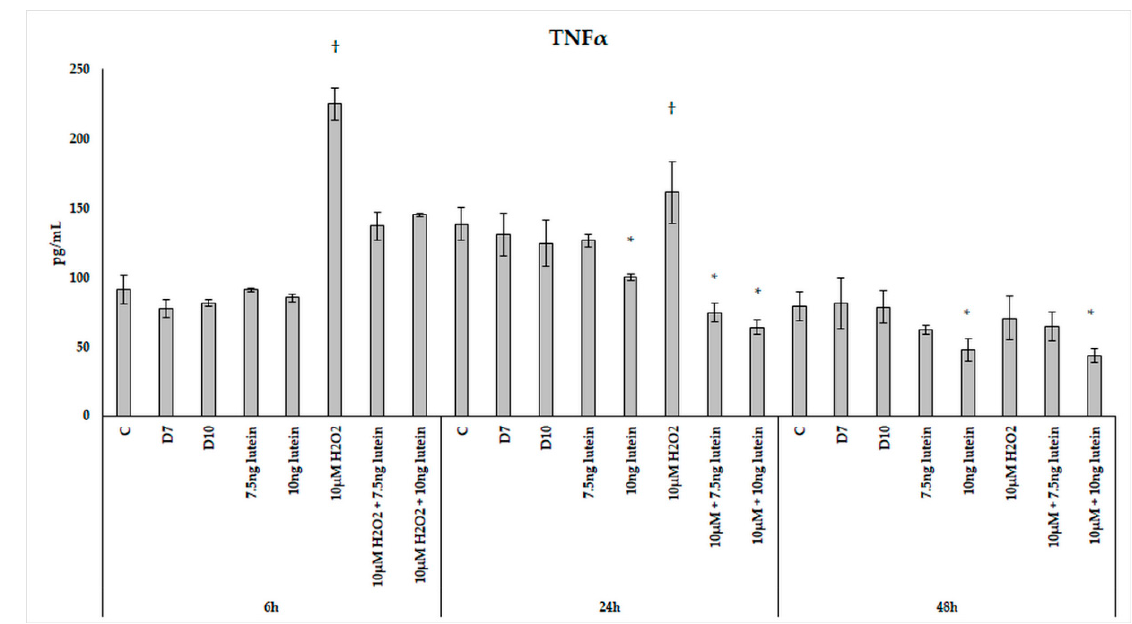
Figure 15. TNF α secretion in lutein and in H 2 O 2 -treated BV-2 cells. The columns represent the mean values, and error bars indicate the standard deviation (SD) of three independent experiments ( n = 3), each performed in triplicate, and are presented relative to own control cells. * indicates statistical significance of lutein treatments versus controls; † indicates statistical significance of H 2 O 2 -treated cells compared to controls; the level of significance was p < 0.05. Abbreviations: C marks the appropriate absolute controls at 6, 24 and 48 h; D7 means the same amount of DMSO as 7.5 ng/ µ L of lutein was added; D10 means the same amount of DMSO as 10 ng/ µ L of lutein was used in the treatments.